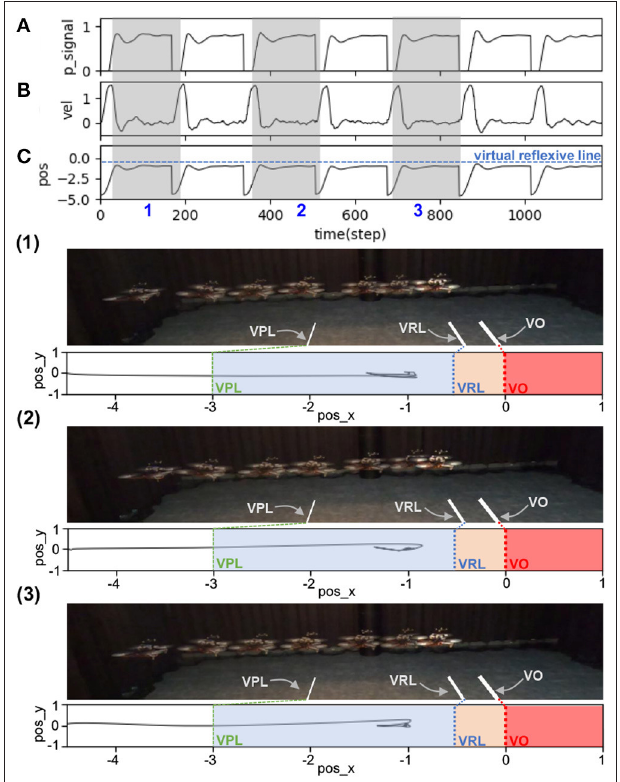
FIGURE C1 | Real-time data when flying the UAV at a maximum speed of 1.25 m/s and using an approximate predictive weight of 1.07 obtained from Figure 7 as the initial weight. Each graph shows: (A) predictive signal, (B) actual speed (x-axis) of the UAV, and (C) position on the x-axis of the UAV compared to the virtual reflexive line (blue line). The gray areas represent three learning periods and show the UAV’s position with respect to the virtual predictive line (VPL), virtual reflexive line (VRL), and virtual obstacle (VO), as in three snapshots together with the corresponding estimated trajectories (1, 2,